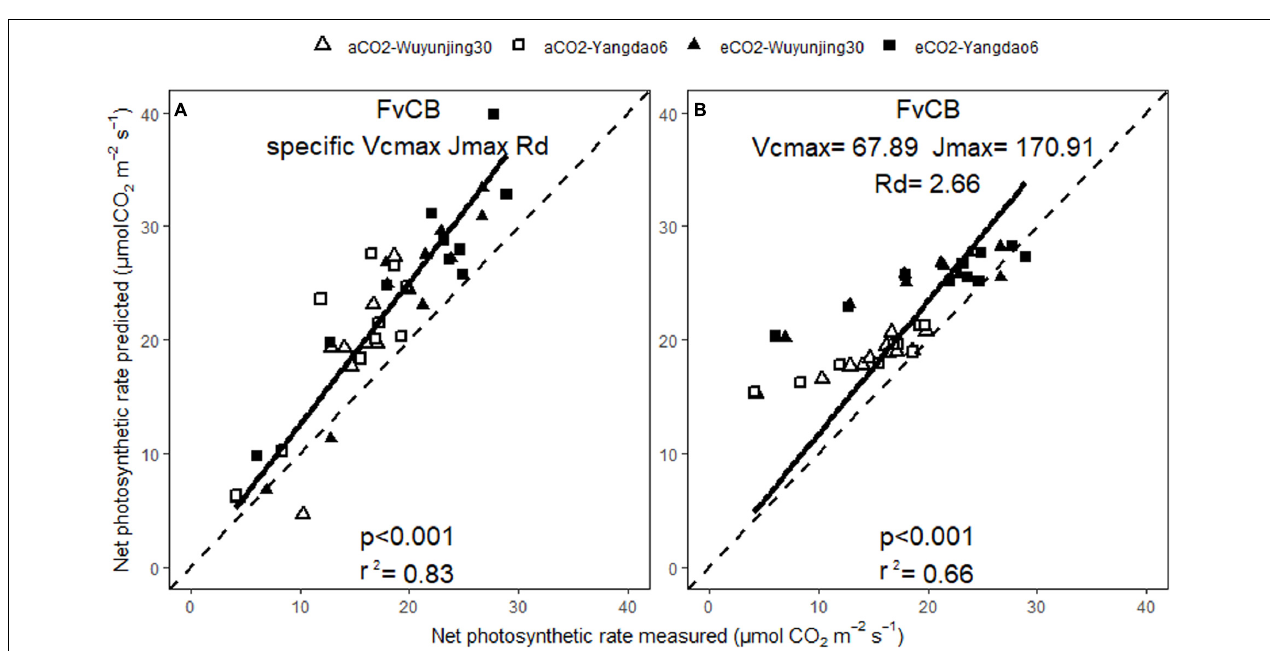
FIGURE 5 | Relationships between the measured and simulated daily average net photosynthetic rate for the two rice cultivars at ambient and elevated (CO 2 ) throughout the growing season. Net photosynthetic rate was simulated with FvCB model using either specific model parameters (A) or generic model parameters (B) . p value of the correlation analysis and the square of Pearson correlation coefficient (r 2 ) are given.